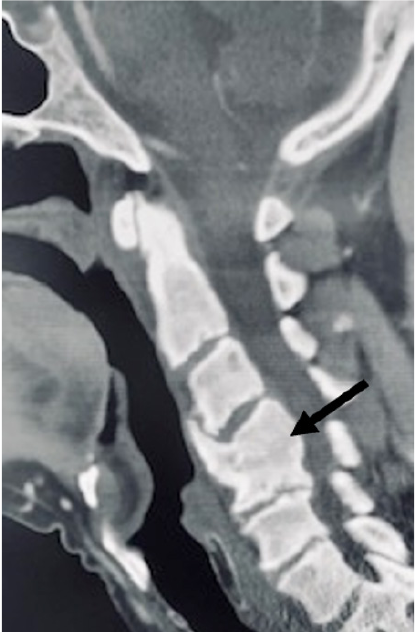
Image 3. Computed tomography scan of sagittal plane of cervical spine showing fourth and fifth cervical fusion (arrow) two years after initial